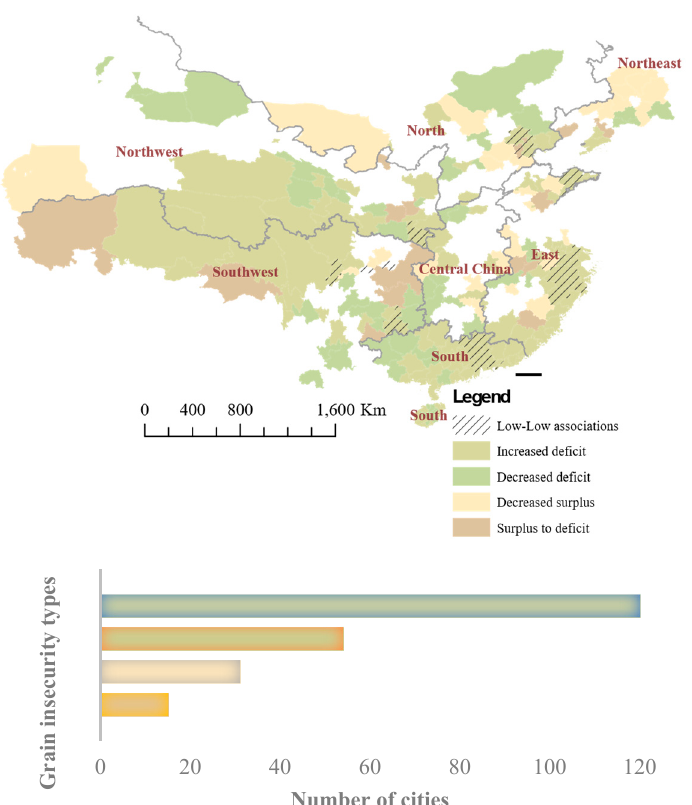
Figure 2. Distribution and number of cities with grain insecurity based on variations in grain supply– demand conditions from 2008 to 2018. Where the oblique line denotes the low–low associations, hotspots of grain insecurity are indicated. The total of 357 cities is disaggregated by grain supply– demand